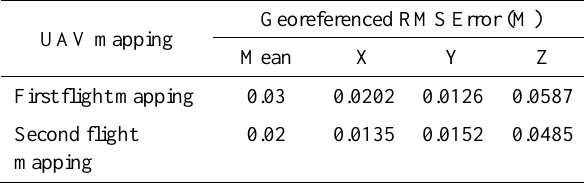
Table 4. Map accuracy of fix-wing UAV